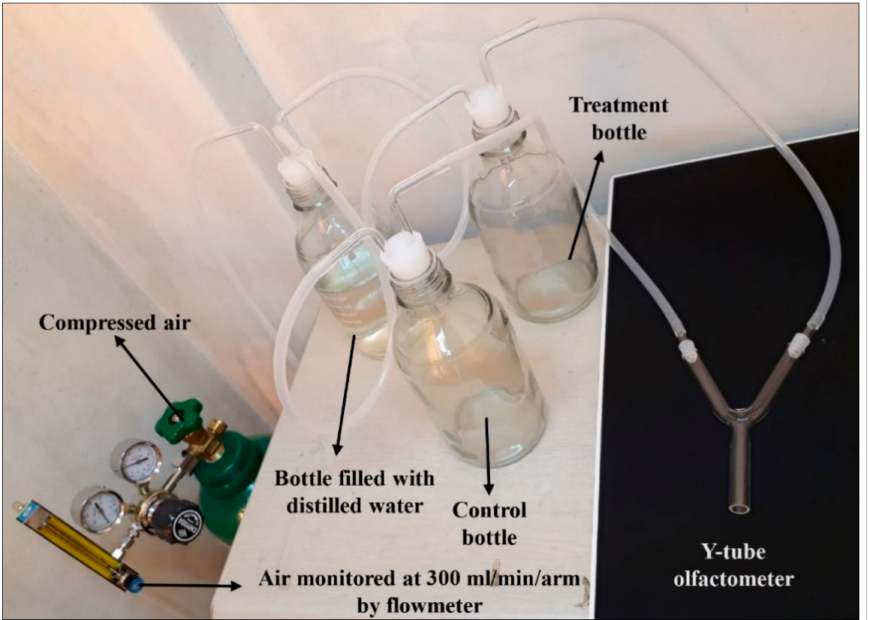
Figure 1. The Y-tube olfactometer apparatus used to investigate the olfactory responses of the honey bees for each component of the bloom thinning